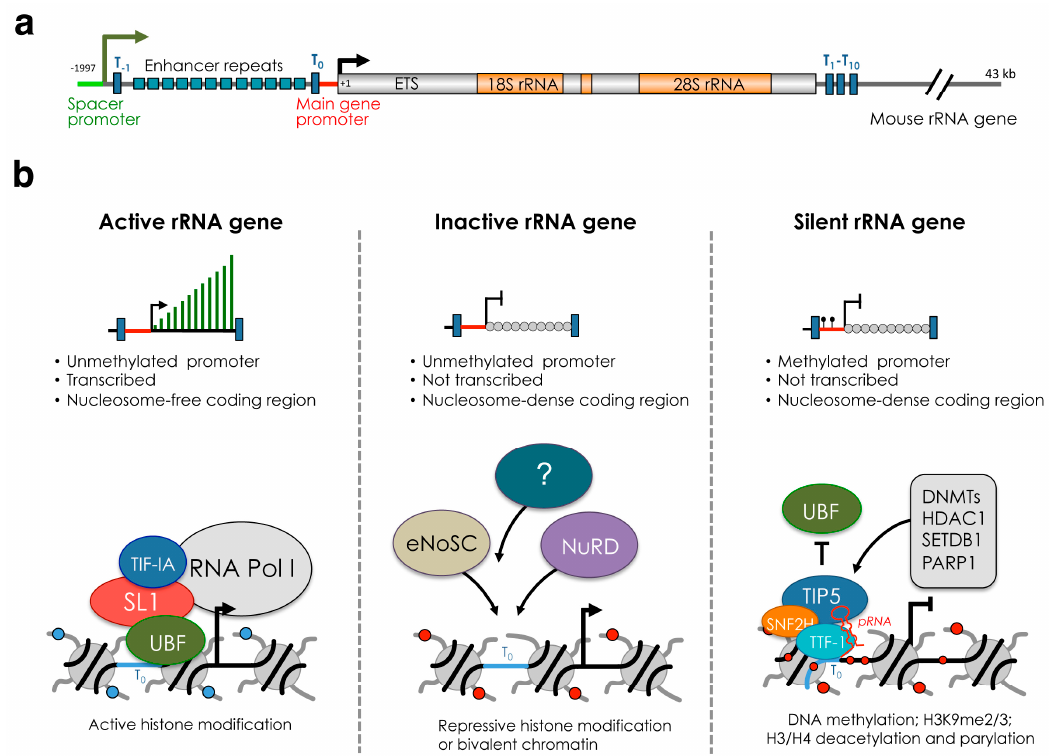
Figure 1. The three major classes of rRNA genes. ( a ) Structural organization of mouse rRNA gene. The sites of transcription initiation of the 45S pre-rRNA from the main gene promoter and IGS-rRNA transcripts from the spacer promoter are indicated by arrows. Terminator elements downstream of the spacer promoter (T-1), upstream of the main gene promoter (T0), and downstream of the coding regions (T1-T10) are marked by blue bars. The repeats composing the enhancer (13 according to the sequence from Genbank accession number BK000964) are shown. ETS, external transcribed spacer. ( b ) Description of active, inactive and silent rRNA genes based on transcription, chromatin and epigenetic state and factors regulating their state. The binding of UBF and NoRC (TIP5 and SNF2H) define active and silent rRNA genes. Inactive rRNA genes are non-transcribed repeats that lack promoter DNA methylation, are nucleosome-packed at the coding region, and are not bound by UBF or NoRC. The structure of inactive genes can be mediated by the nucleosome remodeling and deacetylase (NuRD) complex, the energy-dependent nucleolar silencing complex (eNOSC) or other yet unknown regulators.